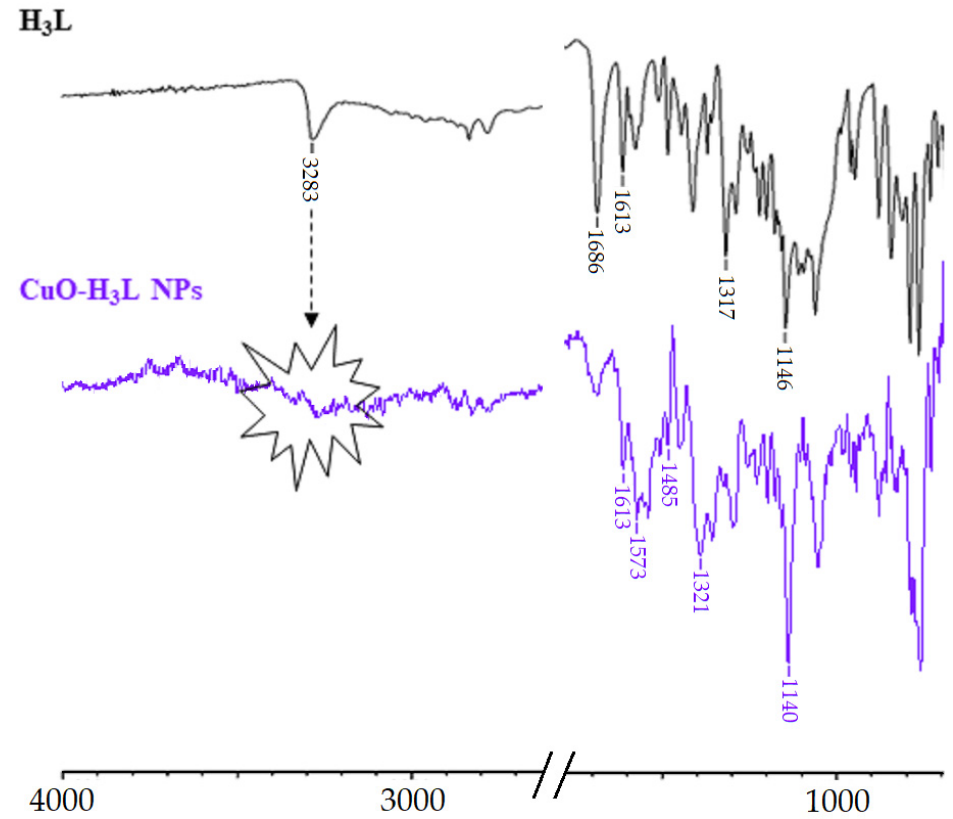
Figure 9. Partial view of the ATR-FTIR spectra of the free ligand (top) and CuO-H 3 L NPs.